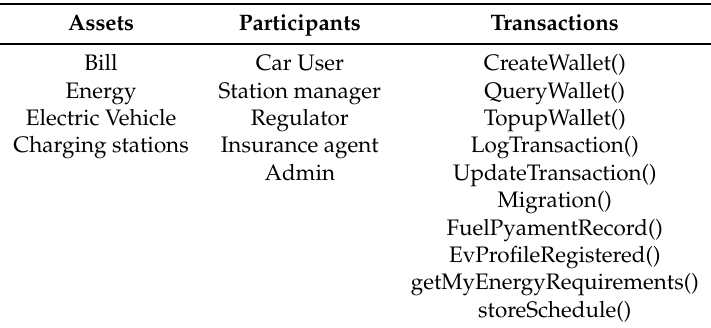
Table 1. Blockchain business network components.